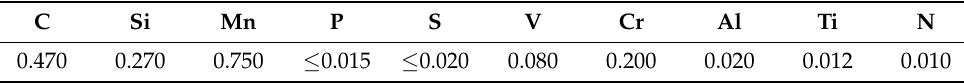
Table 1. Chemical compositions of the experimental steel